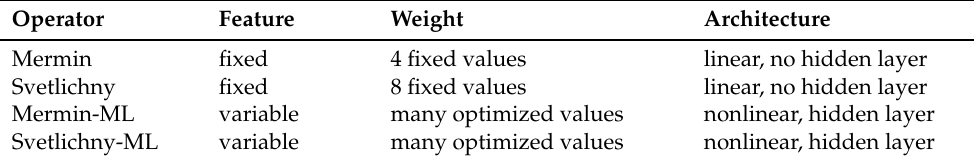
Table 1. Integrating Mermin and Svetlichny inequalities with machine learning. Operator Feature Weight Architecture Mermin fixed 4 fixed values linear, no hidden layer Svetlichny fixed 8 fixed values linear, no hidden layer Mermin-ML variable many optimized values nonlinear, hidden layer Svetlichny-ML variable many optimized values nonlinear, hidden